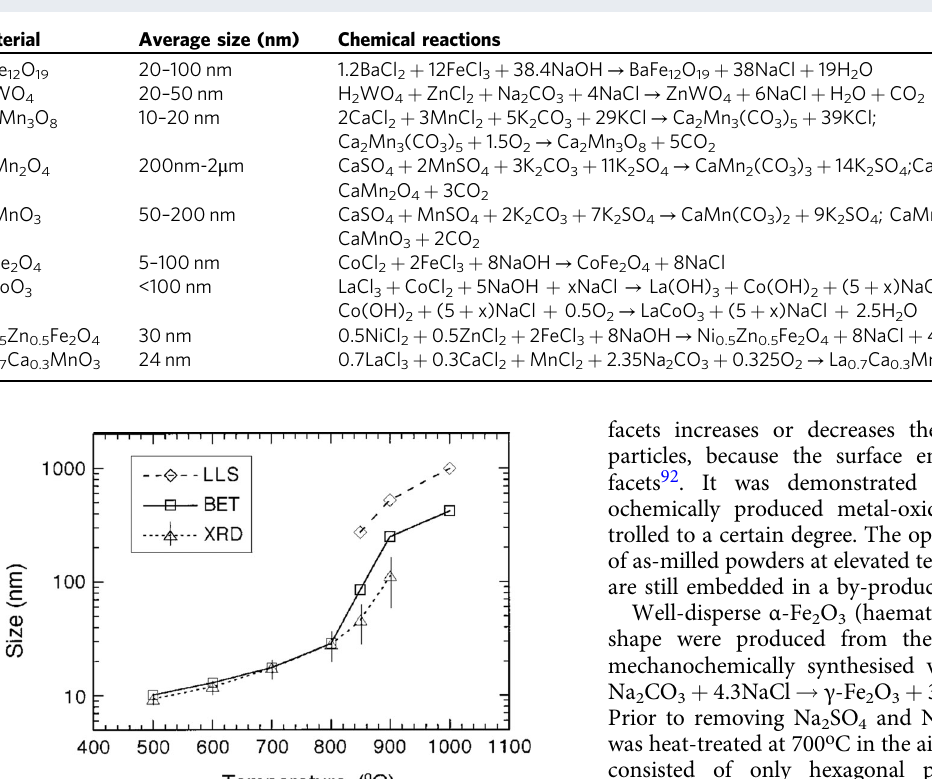
Table 3 Tertiary metal-oxide nanoparticles produced using the mechanochemical activation of solid-state displacement reactions.